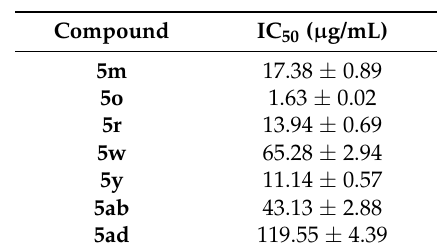
Table 4. IC 50 of the selected compounds on NIH/3T3 mouse embryonic fibroblast cell lines (ATCC CRL1658).